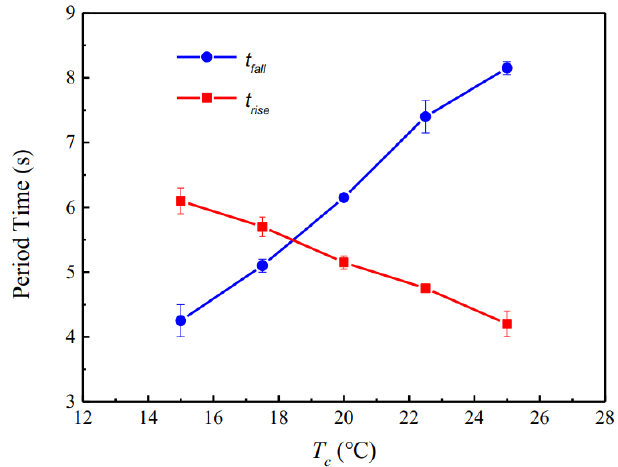
Figure 13. Measured rising time and falling time at different cooling temperatures.